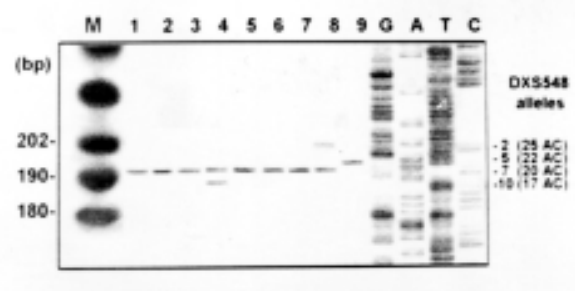
Figure2 -PCR-amplifiedDXS548alleles:line4showsallele10(17CA), not reported previously. pBR322 MspI-digested fragments (M) and gt11 α - 35 S-labelled sequencing plasmid (GATC) were used for allele